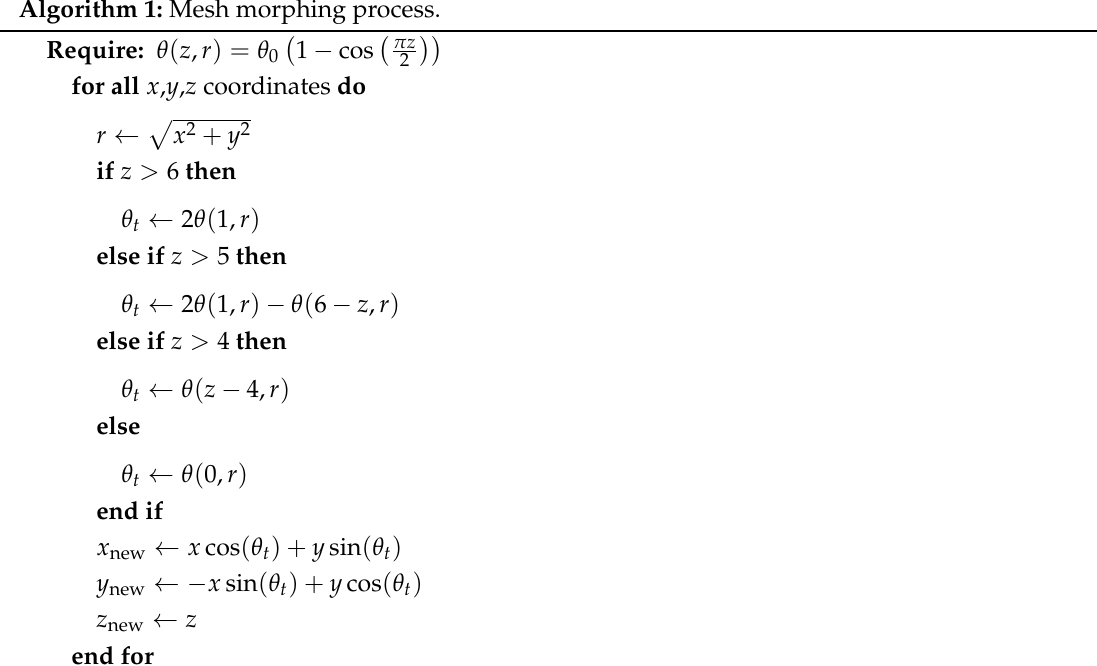
Algorithm 1: Mesh morphing